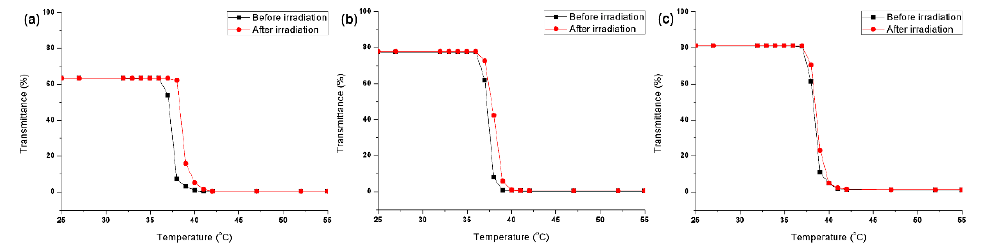
Figure 6. Dual stimuli-responsive behaviors of DRBCP micelles in aqueous solution at 5 mg/mL concentration. ( a ) DRBCP1b. ( b ) DRBCP1c. ( c ) DRBCP2. concentration. ( a ) DRBCP1b. ( b ) DRBCP1c. ( c )